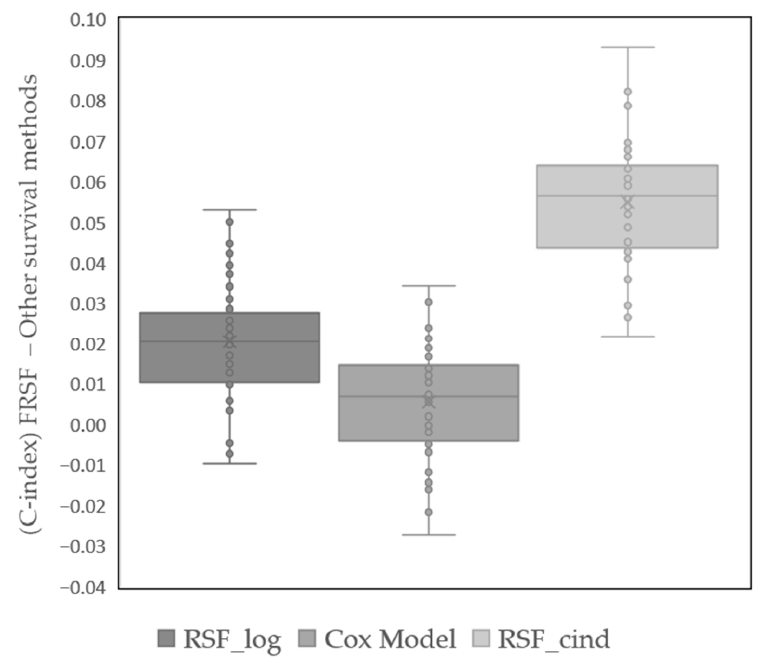
Figure 6. C-index difference between FRSF and each survival model using the original dataset (n_100).